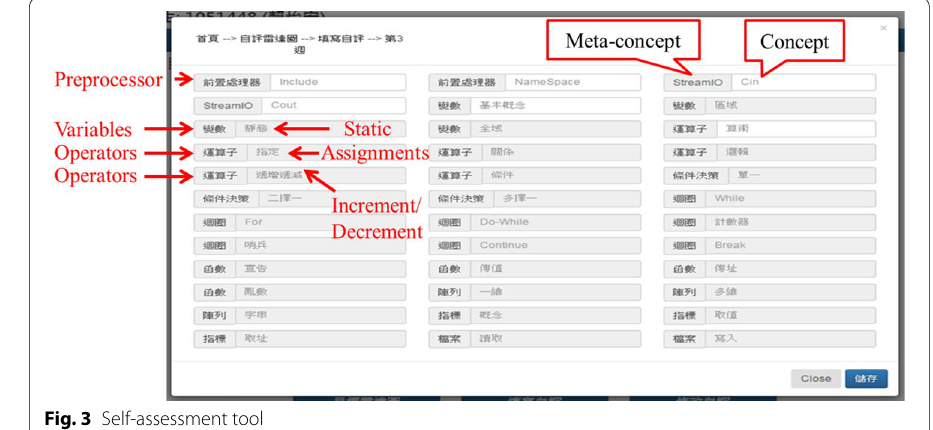
Fig. 3 Self‑assessment tool